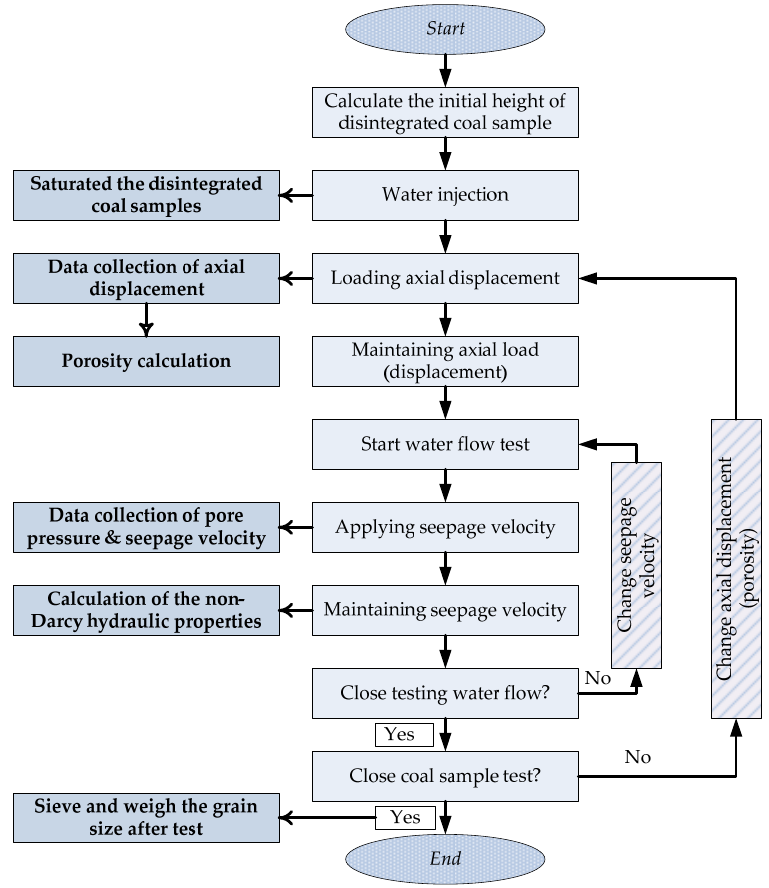
Figure 7. Testing procedure of the non-cemented coal.